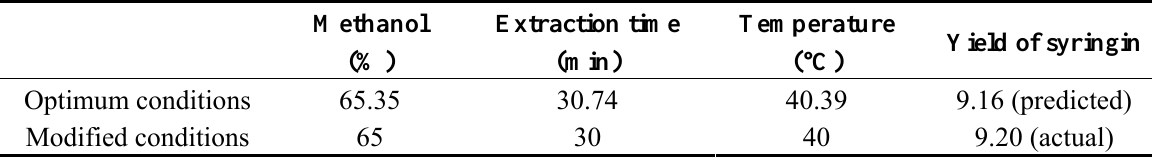
Table 4. Optimum conditions and the predicted and experimental yield at the optimum